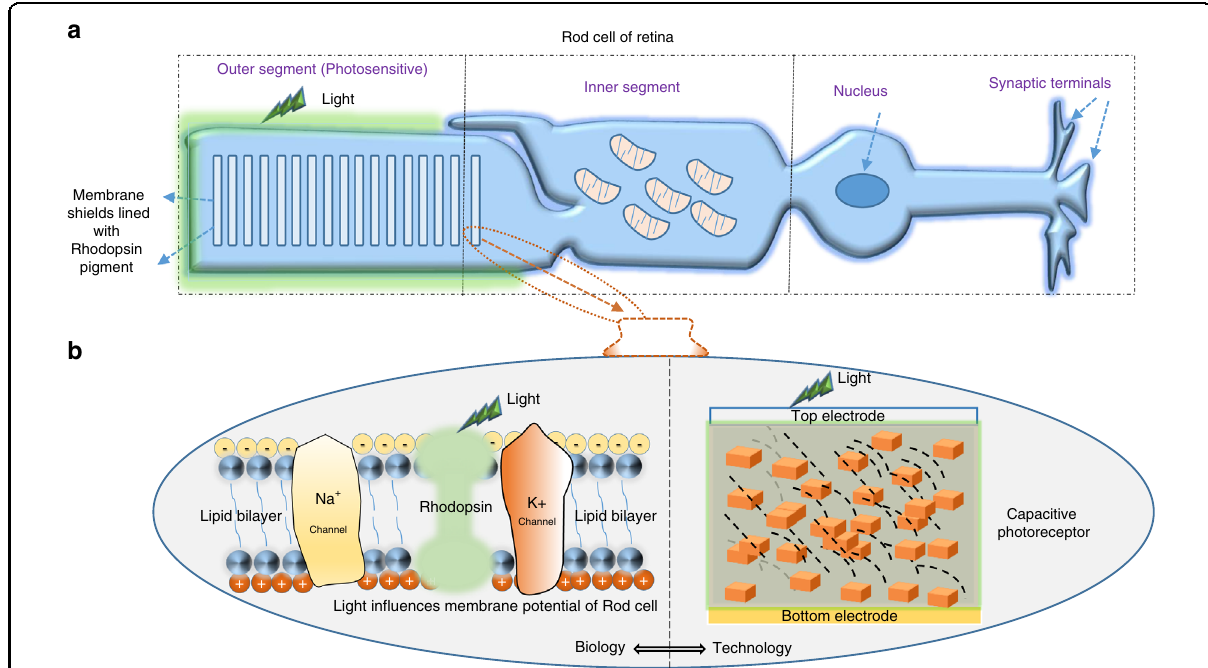
Fig. 1 A closer look into the rod cell of mammalian ’ s retina. a Schematic of the typical Rod cell in mammalian ’ s retina. The rod cells absorb light in the retina and transmit signals to the brain. The outer segment of the rod cell comprises disc membranes lined with rhodopsin, which contains photosensitive pigments. b Illustrative comparison of rod cell membrane potential in the retina and the fabricated capacitive photoreceptor. Light induces the change in membrane potential of rod cells in the retina. The pigments in the rhodopsin absorb light and in fl uence Na + ion fl ow, which results in the hyperpolarization of the Rod cell. Similarly, light induces a change in the capacitance of the devised